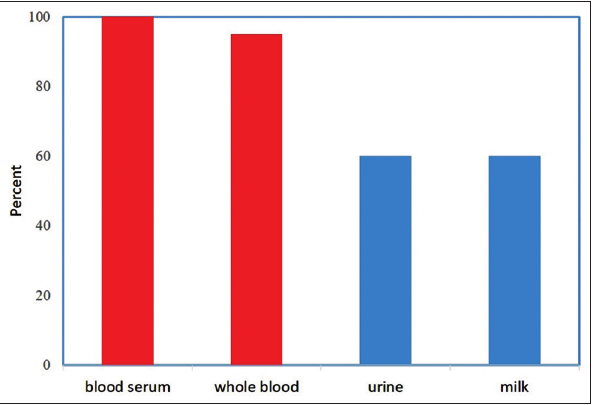
Figure 2: Relative βHBA share in cows body fluids